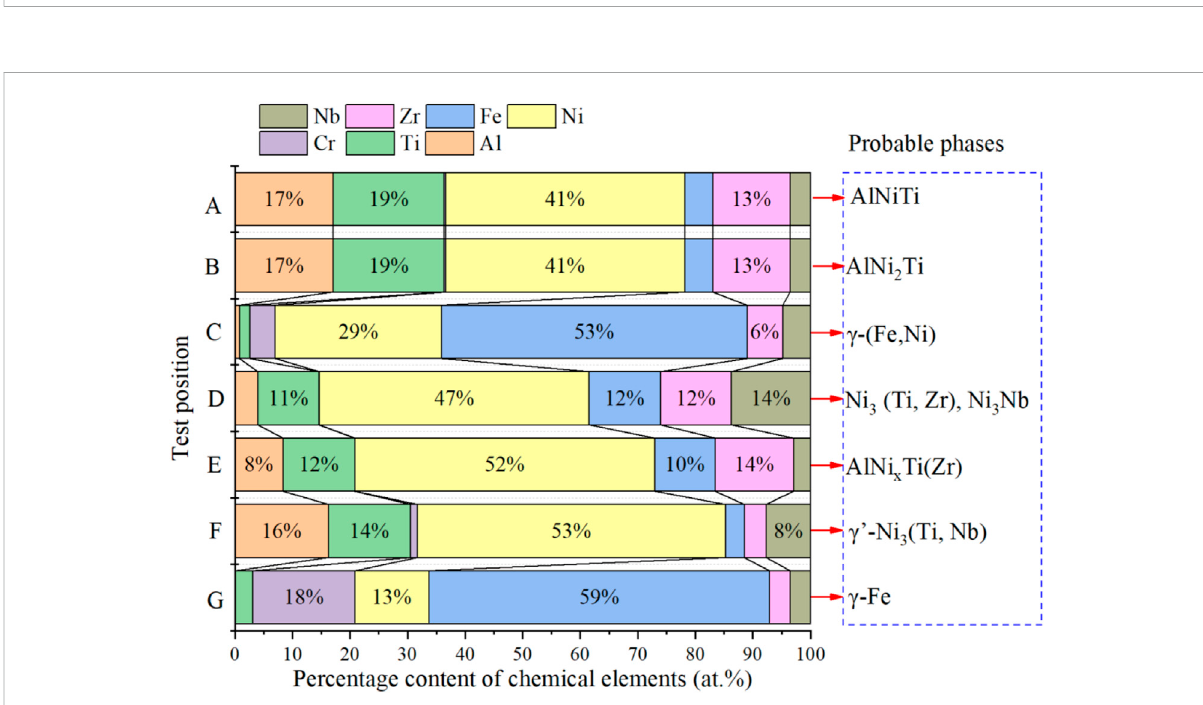
FIGURE 7 EDS results of the scanning zone marked in Figure 5 with